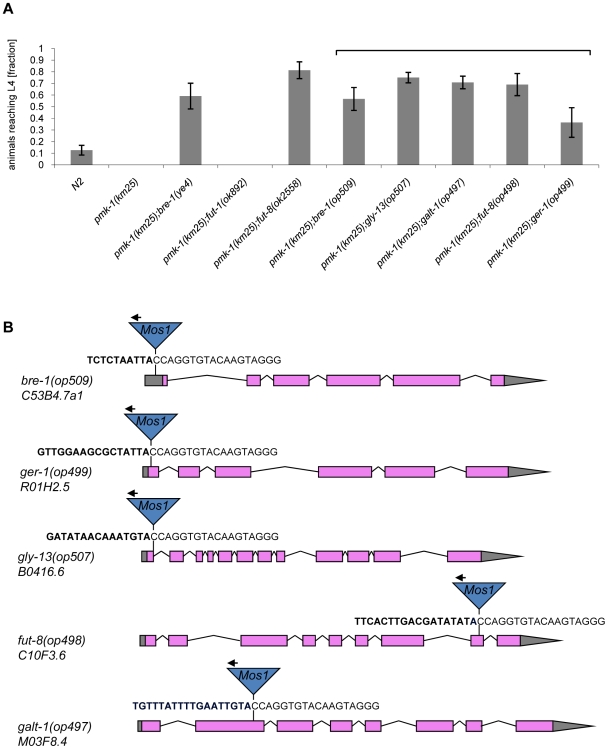
Results of the forward genetic screen for CGL2-resistant C. elegans mutants.(A) Resistance of isolated and constructed C. elegans mutants towards CGL2-mediated toxicity. C. elegans mutants of the indicated genotypes were analysed for development from L1 to L4 as outlined above. The gene appendix (op) and the bracket above the histogram indicate mutants isolated in the Mos1-screen. The other mutants were constructed by crossing. The increase in the fractions of animals reaching L4 of the various mutants compared to N2 worms was statistically significant (p<0.05). In case of the pmk-1 and the pmk-1;fut-1 mutant, not a single larva developed, so results were not compared statistically. (B) Insertion sites of Mos1 elements in CGL2-resistant mutants. Arrows above Mos1 elements indicate the orientation of the Mos1 primer oJL115 used for sequencing iPCR products of mutant lysates. Bold letters indicate C. elegans genomic sequences and are followed by Mos1 sequence. Gene models are taken from WormBase Release WS207. bre-1(op509) mutants have a Mos1 insertion in the 5′-UTR of C53B4.7a1, located 184 bp upstream of the translational start codon. ger-1(op499) mutants have a Mos1 insertion in the first exon of R01H2.5, located 50 bp downstream of the translational start codon. gly-13(op507) mutants have a Mos1 insertion in a conserved splicing donor site flanking the first exon of B0416.6. fut-8(op498) mutants have a Mos1 insertion in the eighth exon of C10F3.6. galt-1(op497) mutants have a Mos1 insertion in the second exon of M03F8.4.